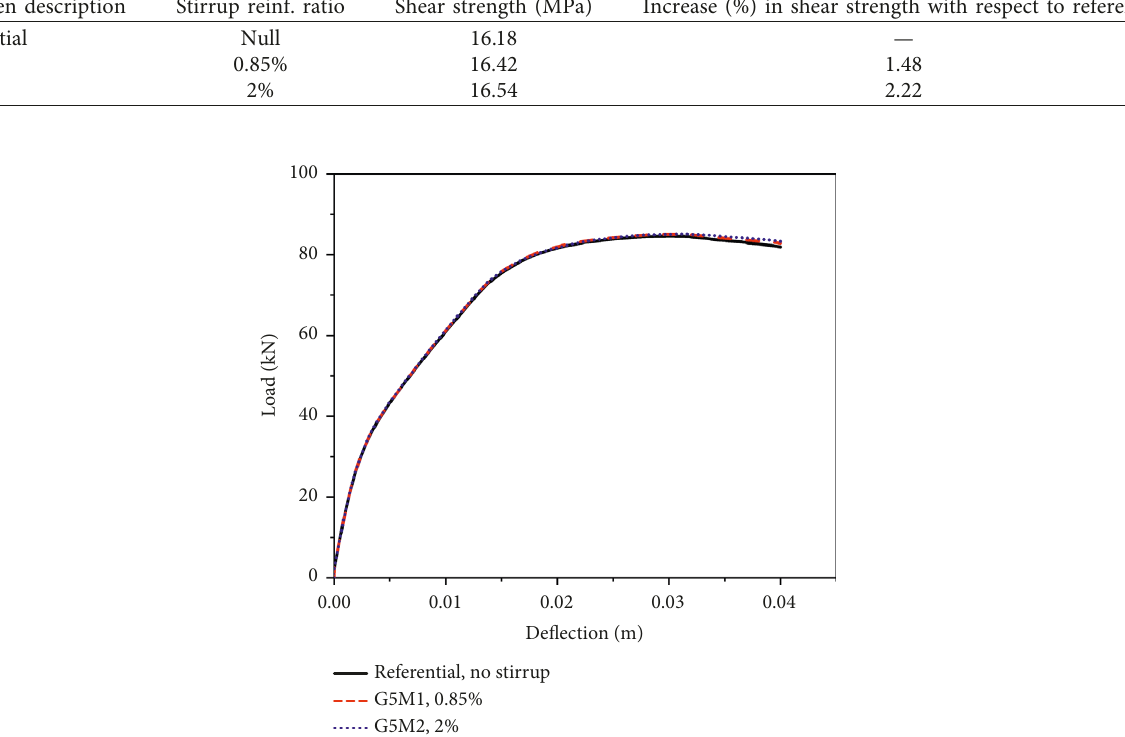
Table 18: Shear strength response of specimens with different stirrup reinforcement ratios. Specimen description Stirrup reinf. ratio